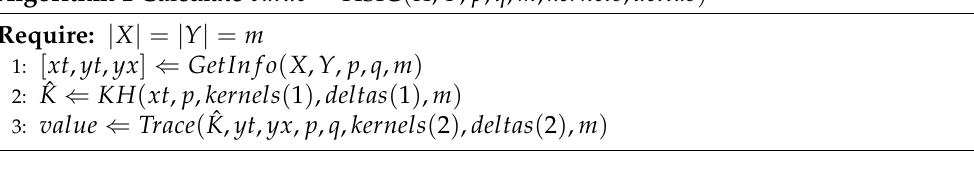
Algorithm 1 Calculate value = HSIC ( X , Y , p , q , m , kernels , deltas )